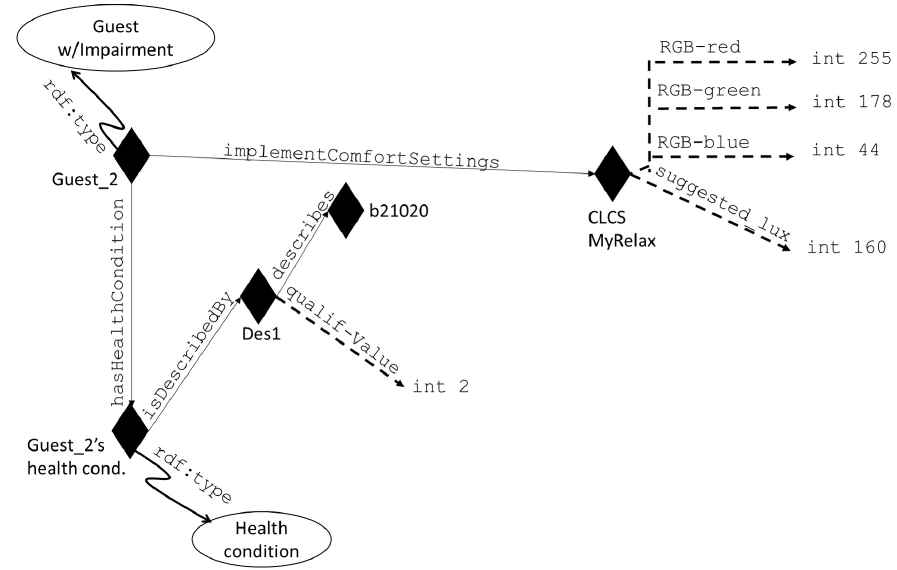
Figure 5. An example of the modelling of a Customized Luminous Comfort Setting (CLCS) for a traveller characterized by visual impairment. Individuals are represented with diamonds, concepts are represented with circles, and roles are represented with arrows (dashed arrows indicate datatype properties, full-line arrows represent object properties). The type of an individual is stated with a curved